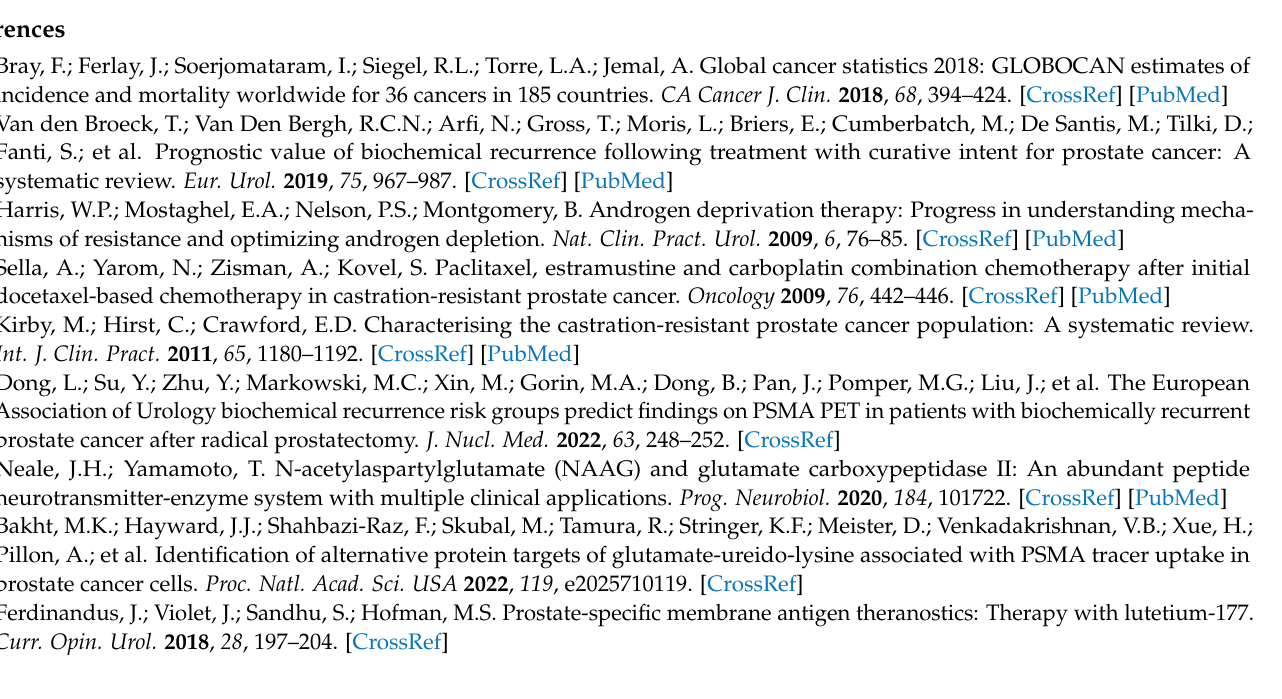
Supplementary Table S2: Overall summary of ADRs; Supplementary Table S3: Change in hemoglobin, leukocyte, platelet, ANC; Supplementary Table S4. The PSA levels at Week 1, 2, 3, 4, 6, 8, and 12